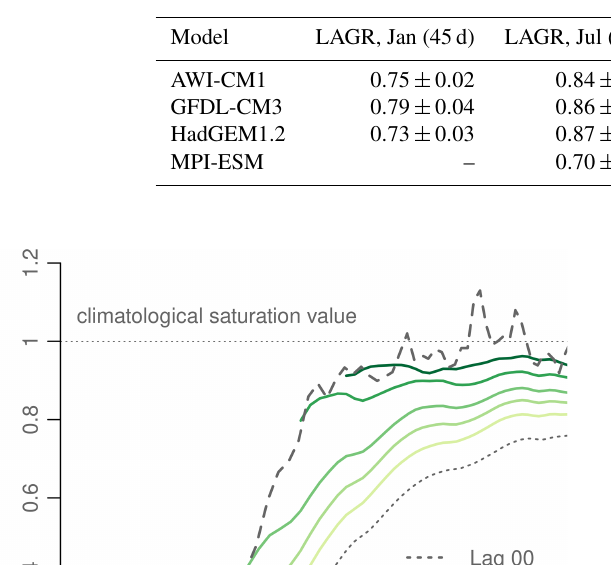
Table 2. Mean normalized uncertainties on the common set of initial positions at a 45 and 12d lead time for the Lagrangian (LAGR) and Eulerian (EULE) perspective, respectively, with 1 standard error.